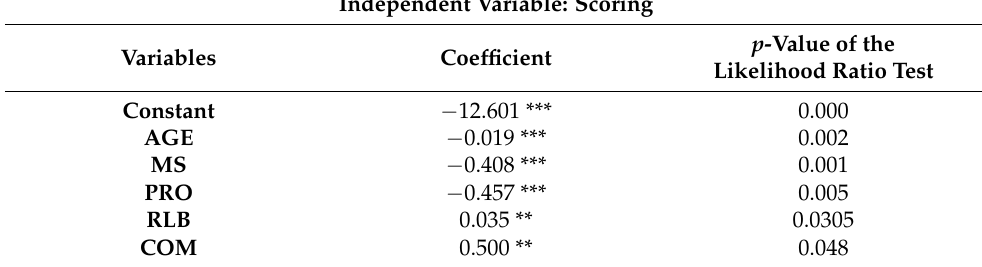
Table 2. Estimation of borrower